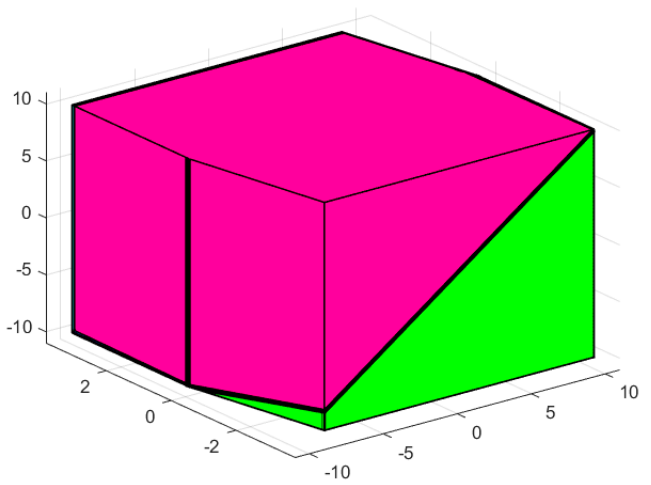
Figure 8. Critical regions. The figure illustrates the critical regions generated by the EMPC controller for the moving trolley system.